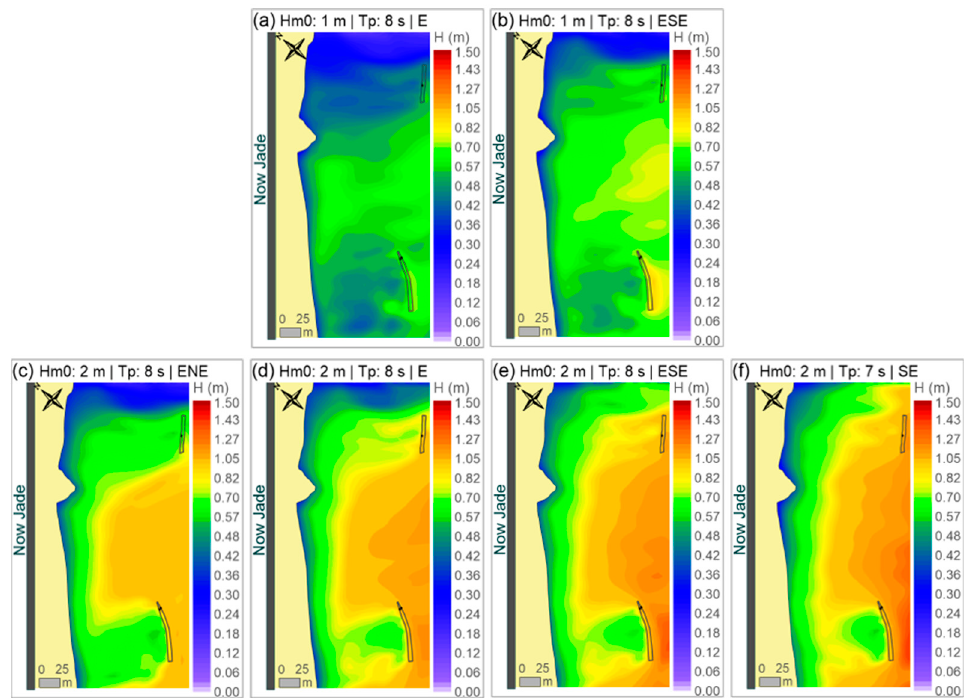
Figure 11. Spatial distribution of wave heights for the scenarios simulated: ( a , b ) non-storm wave conditions; ( c )–( f ) storm wave conditions.